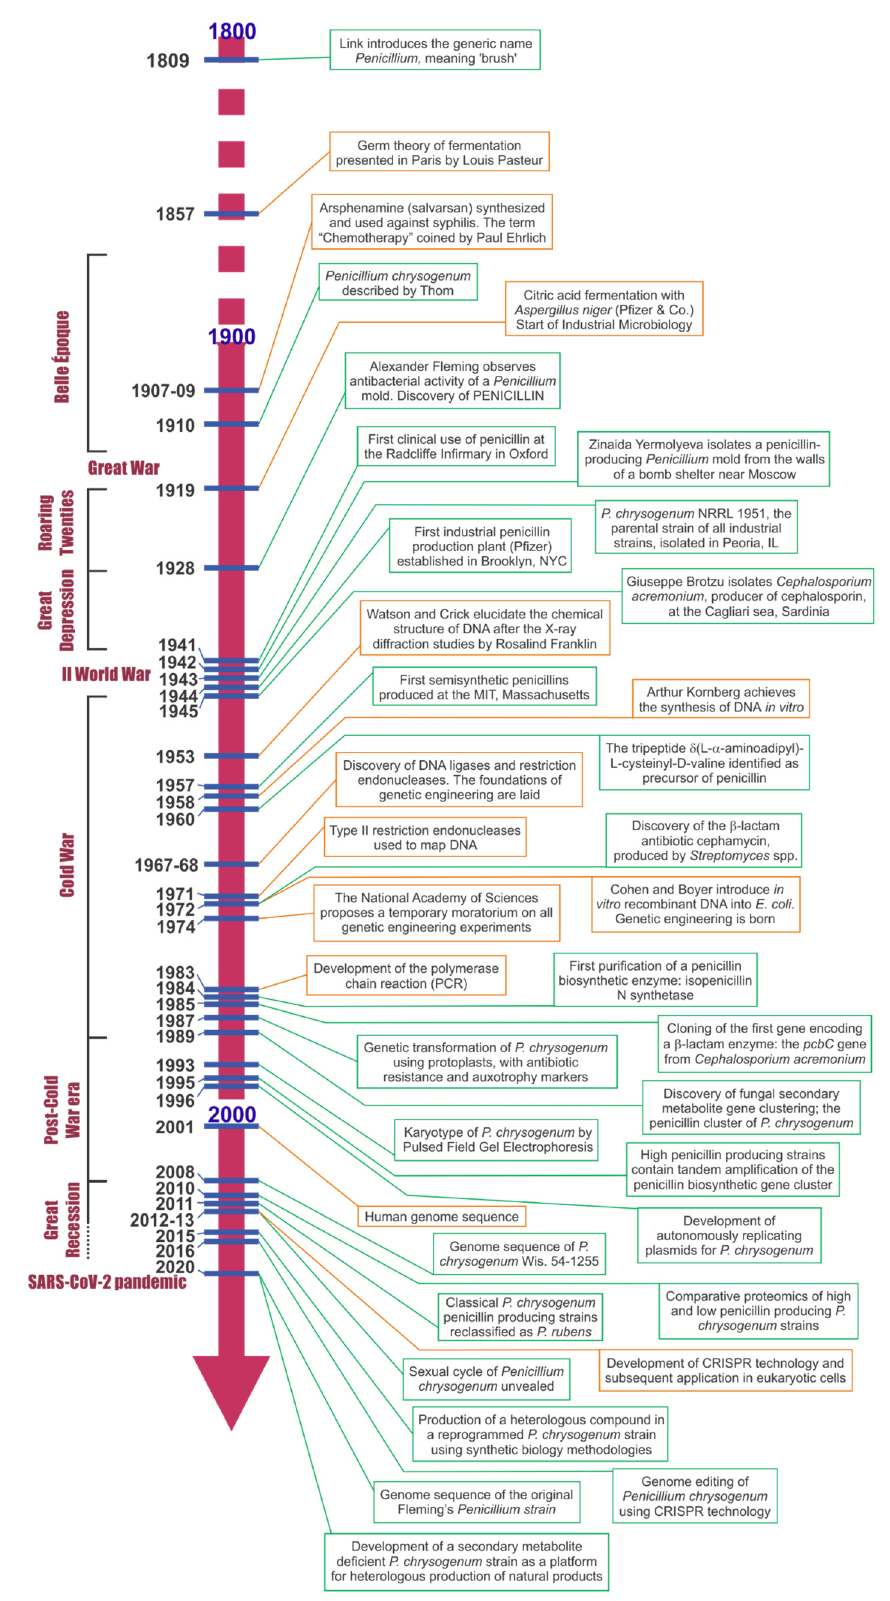
Figure 4. Brief history of the milestones in penicillin discovery, application, and research (green squares), intermingled with relevant scientific and technical developments that had an impact in the penicillin field, with a focus on genetic engineering (brown squares).